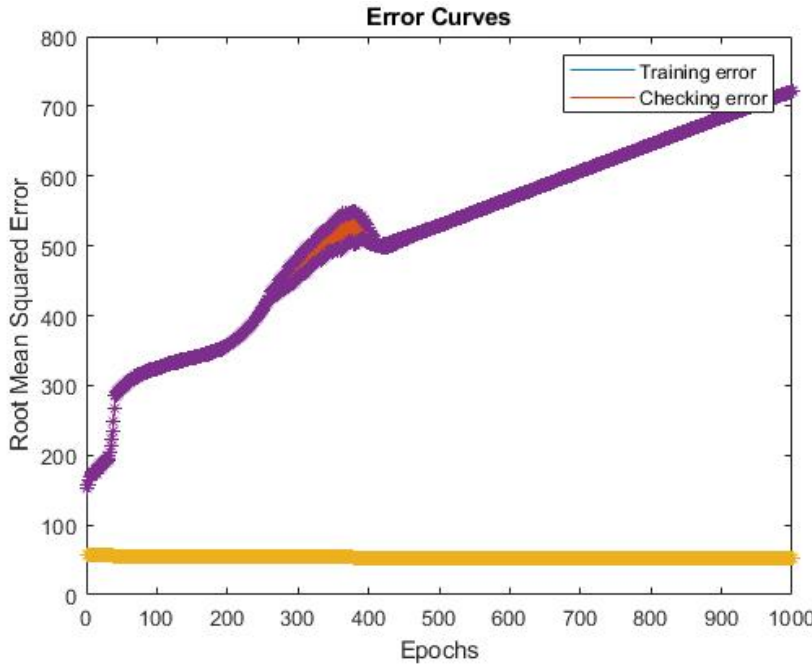
Figure 8. Optimal membership functions of the ANFIS for demand forecasting.